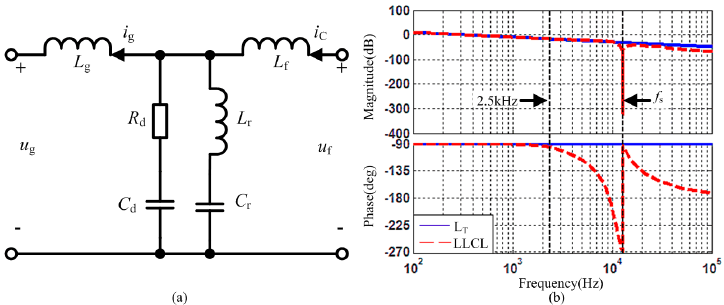
Figure 3. LLCL filter and the Bode plots. ( a ) Single structure of LLCL filter; and ( b ) bode plots of i g (s)/ u f (s).